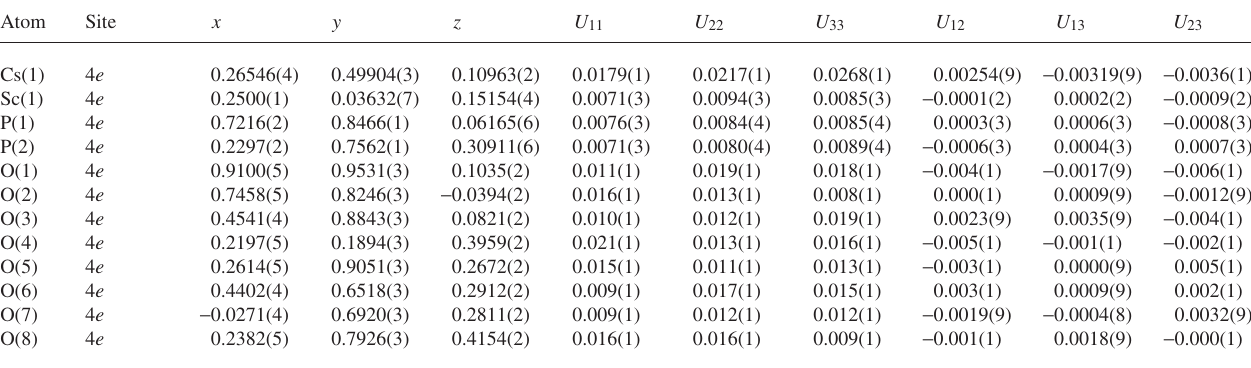
Table 3. Atomic coordinates and displacement parameters (in Å 2 ) .